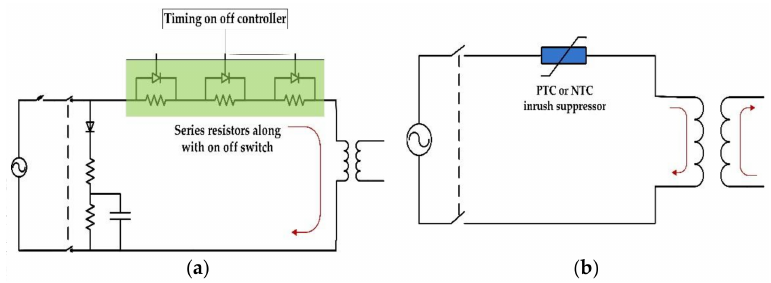
Figure 3. Traditional resistive soft-start